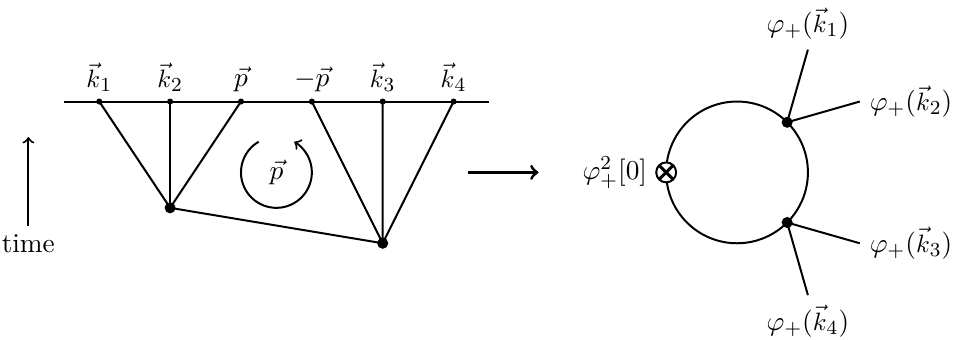
). We start from → ϕ 4 + +